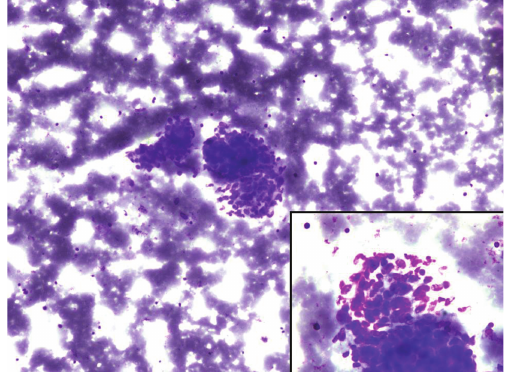
Figure 2: Cytosmear showing loosely cohesive clusters comprising oval to spindle cells in hemorrhagic background (10x, MGG) and inset showing tumor cells having oval hyperchromatic nuclei, inconspicuous nucleoli, and poorly defined cytoplasmic borders (40x,